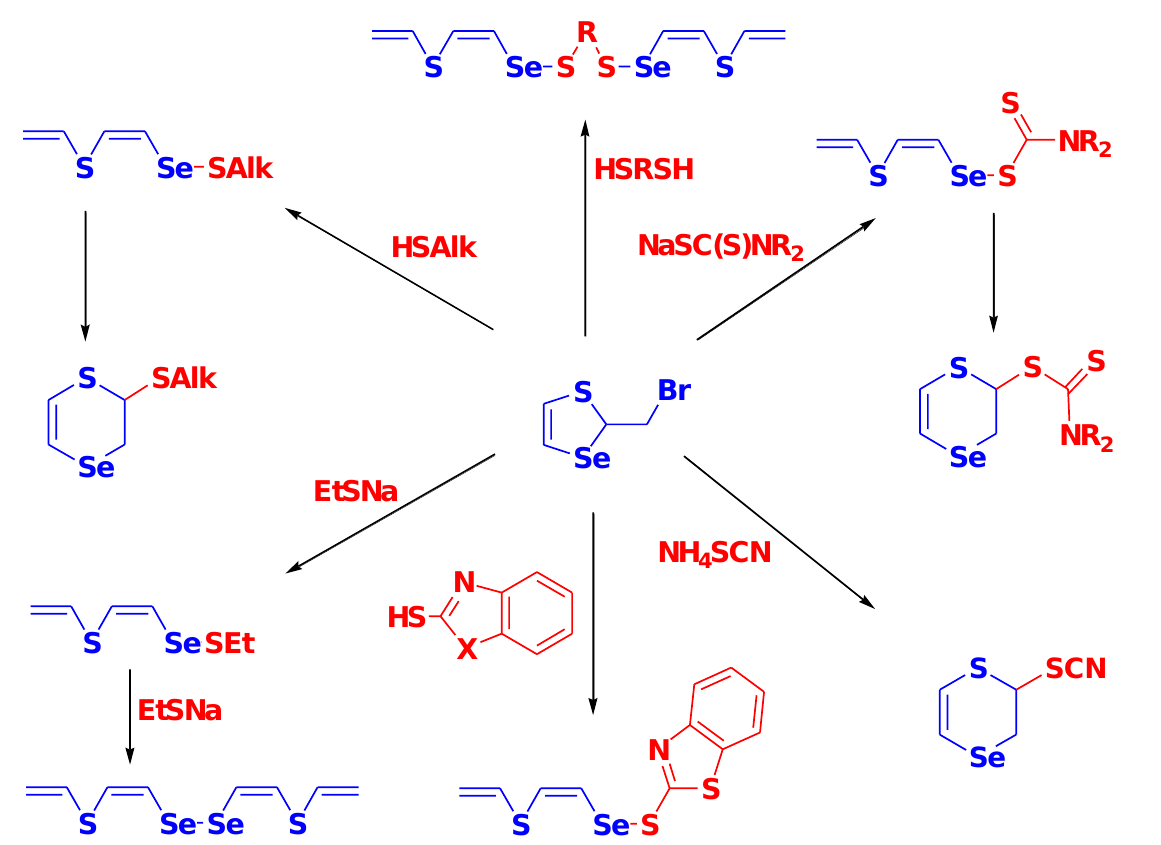
Figure 2. The reactions of 2-bromomethyl-1,3-thiaselenole with sulfur-centered nucleophiles. It is worthy to note that dihydro-1,4-thiaselenines represent a very rare family of compounds.